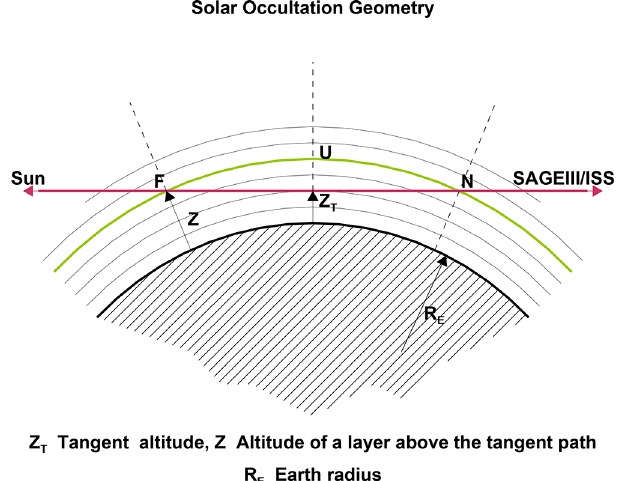
Figure 2. Schematic representation of the solar occultation mea- surement. Z T is the tangent altitude, red line is the LOS, Z is the altitude of a layer above the tangent altitude, F (towards sun) and N (towards SAGE III/ISS) are the points of intersection of layer at Z with the LOS, and R E is the Earth